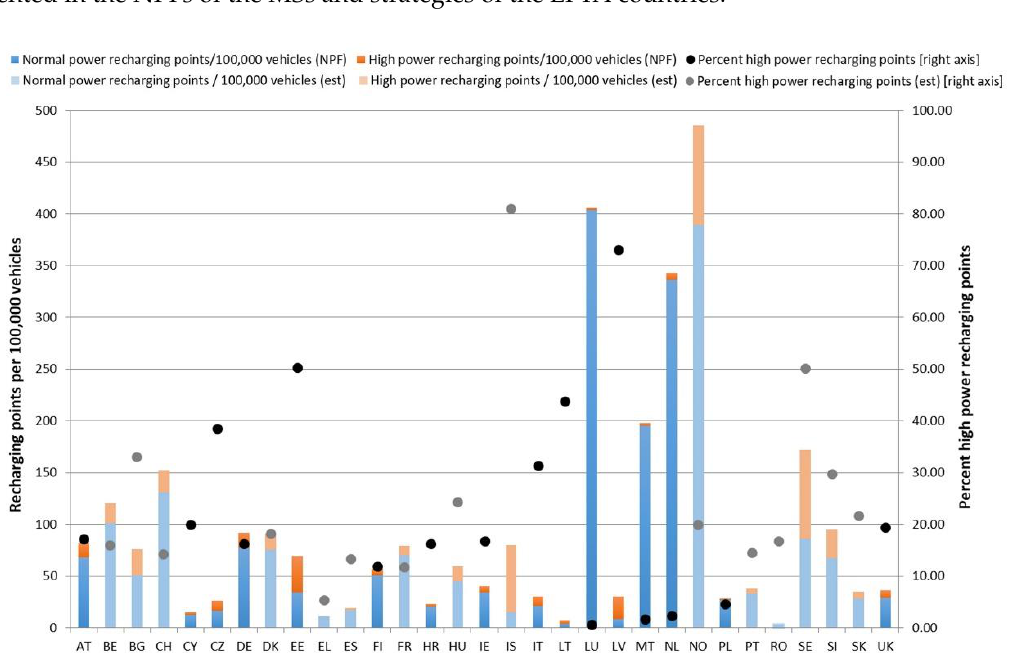
Figure 3. Overview of publicly accessible recharging points per 100,000 vehicles across Europe (2020) according to countries’ strategies (own elaboration on National Policy Framework (NPF) data from [58]).